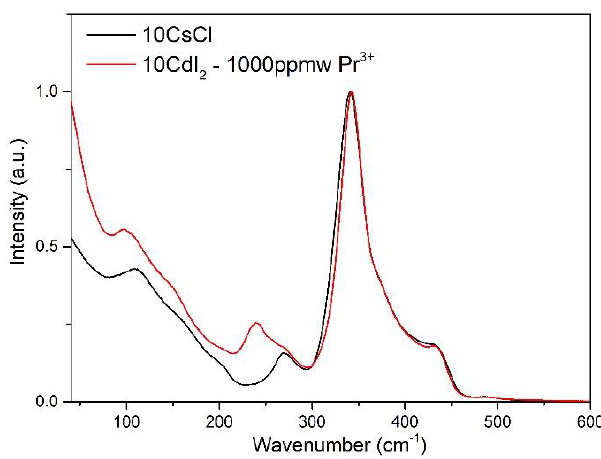
Figure 4 . Raman spectra of the glasses ([GeS 2 ] 0.80 -[Ga 2 S 3 ] 0.20 ) 90 -(CsCl) 10 and ([GeS 2 ] 0.80 -[Ga 2 S 3 ] 0.20 ) 90 - (CdI 2 ) 10 :1000 ppmw Pr 3+ recorded at 785 nm